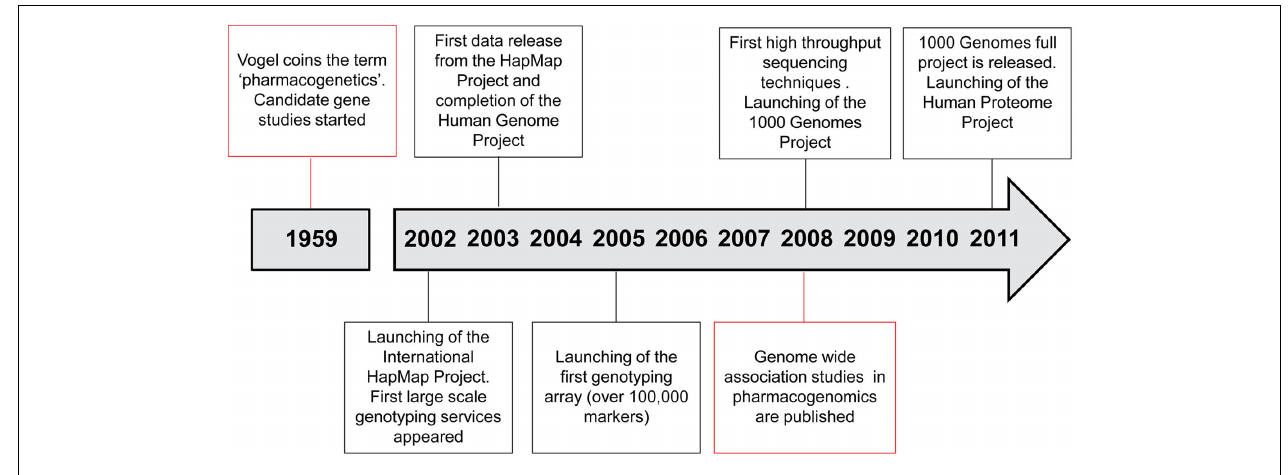
FIGURE 2 |Time line in the genomics/pharmacogenomics